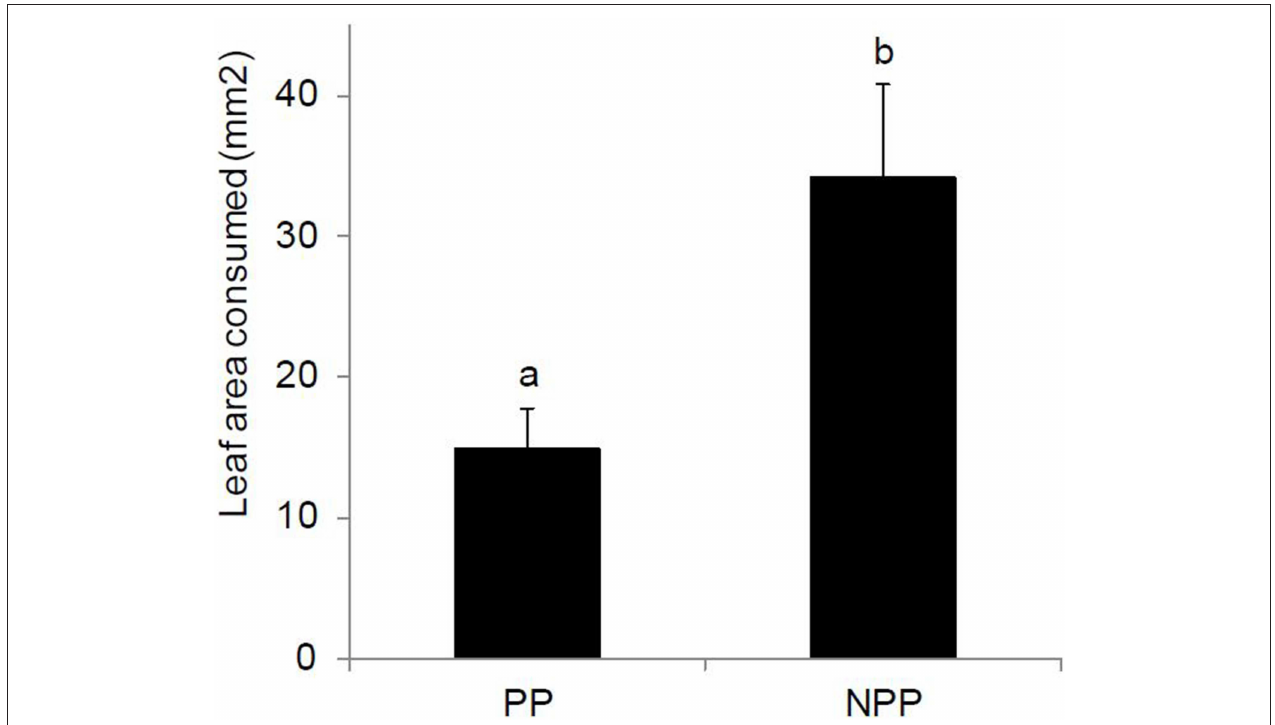
FIGURE 3 | Mean ( ± SEM) maize leaf area consumed by first instar Chilo partellus larvae in a no-choice experiment on plant material grown in soil from Push-Pull (PP) and Non-Push-Pull (NPP) cropping systems. Different letters above the bars indicate significant differences between the means ( P < 0.05 ). N = 44 maize plants.